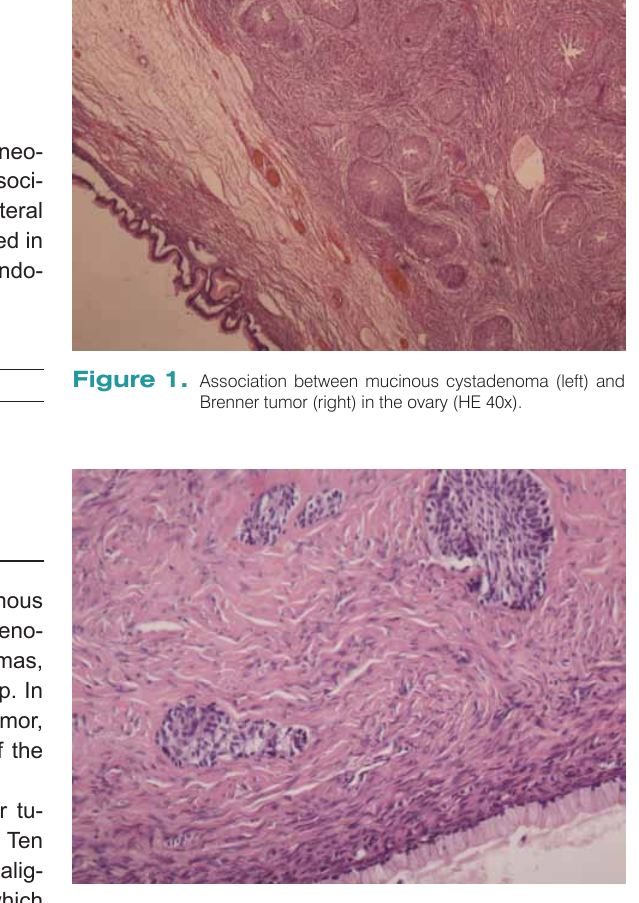
Figure 2. Nests of transitional epithelium surrounded by fibrous stroma (Brenner tumor). On the bottom cylindrical muci- nous epithelium (mucinous cystadenoma) (HEx200).